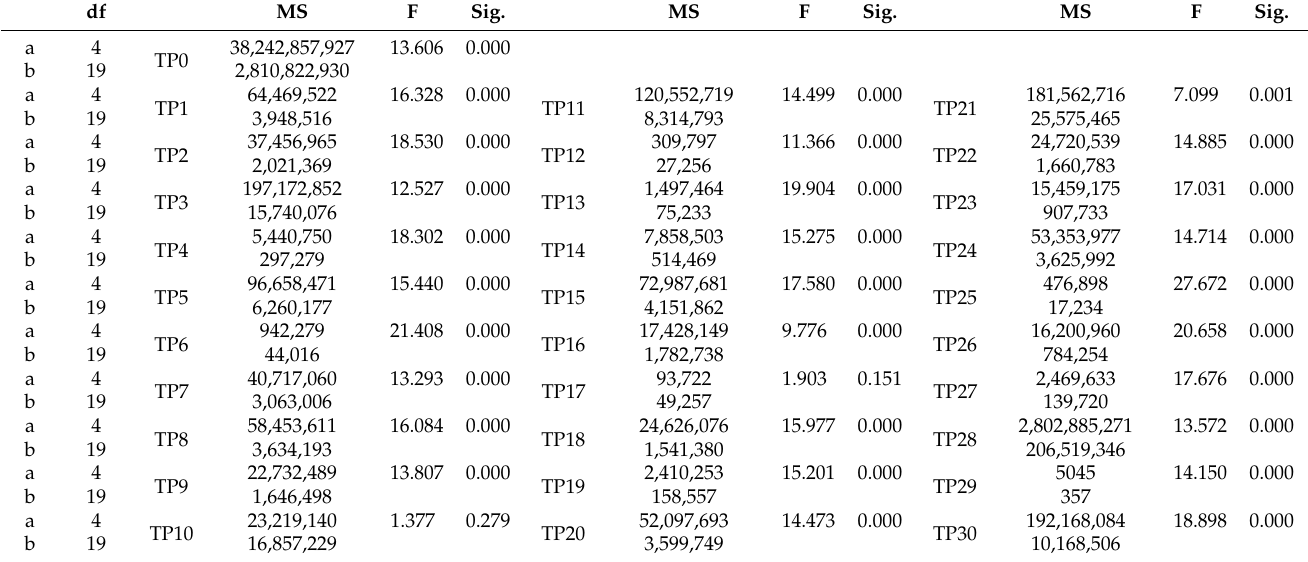
Table 7. ANOVA (Total Population).